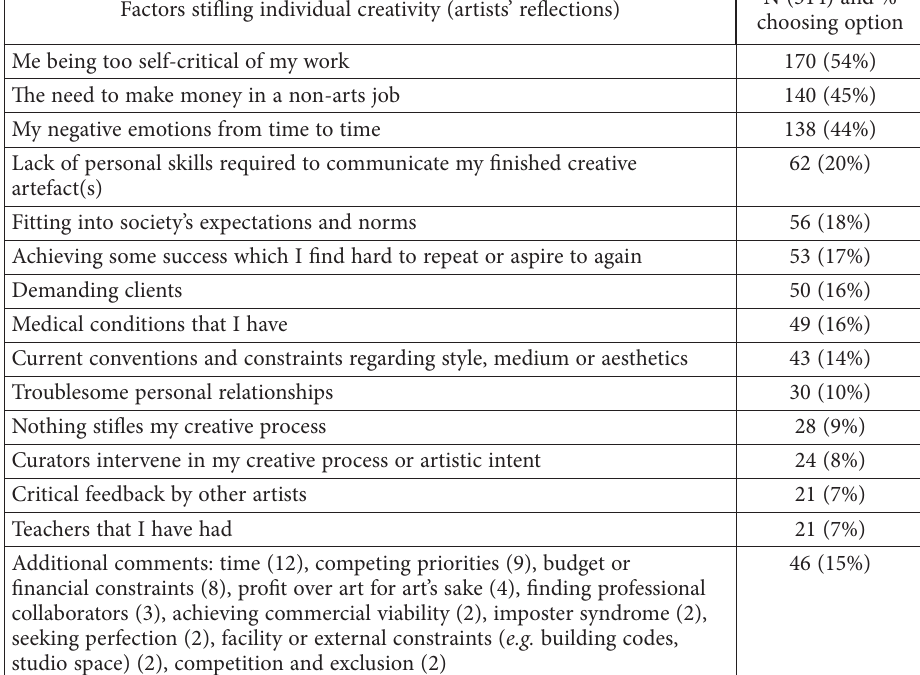
Table 5. Factors stifling individuals’ creativity (source: created by